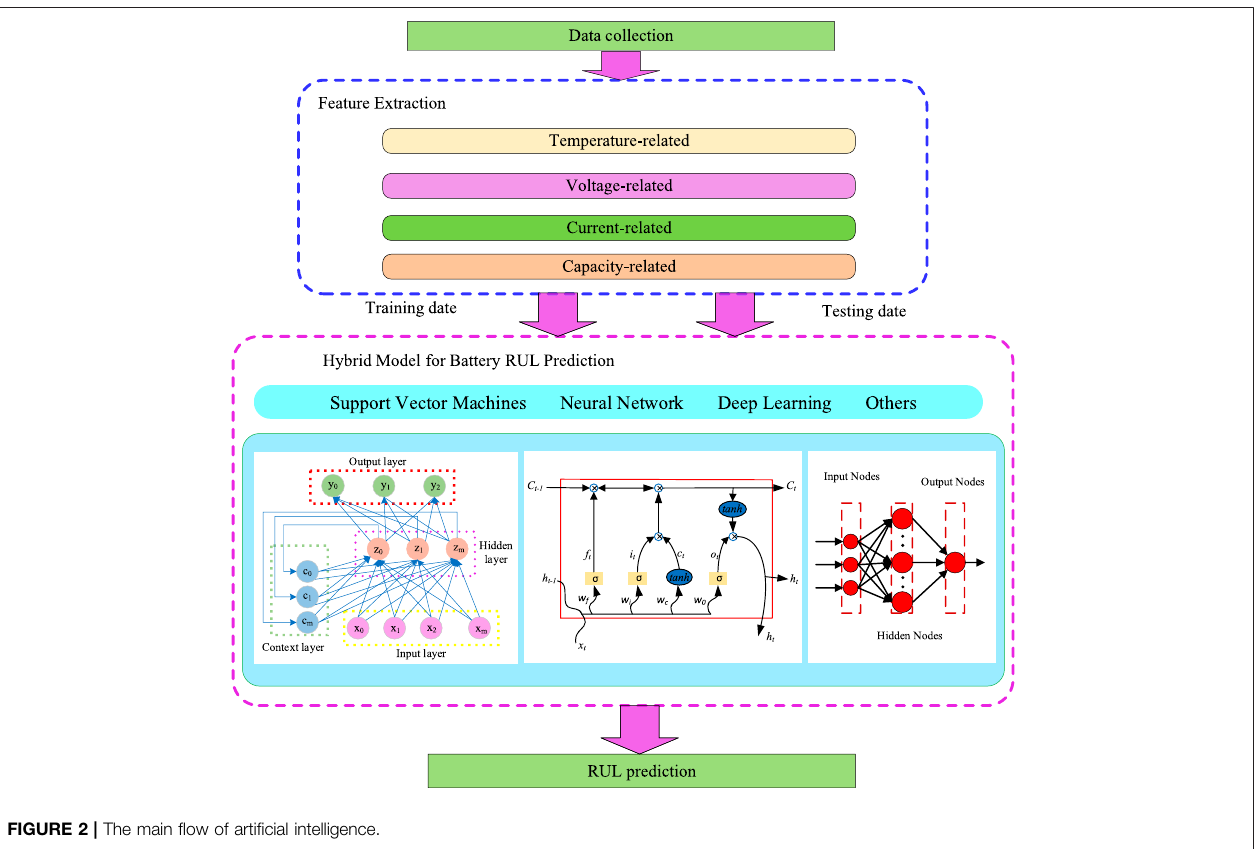
FIGURE 2 | The main fl ow of arti fi cial intelligence.